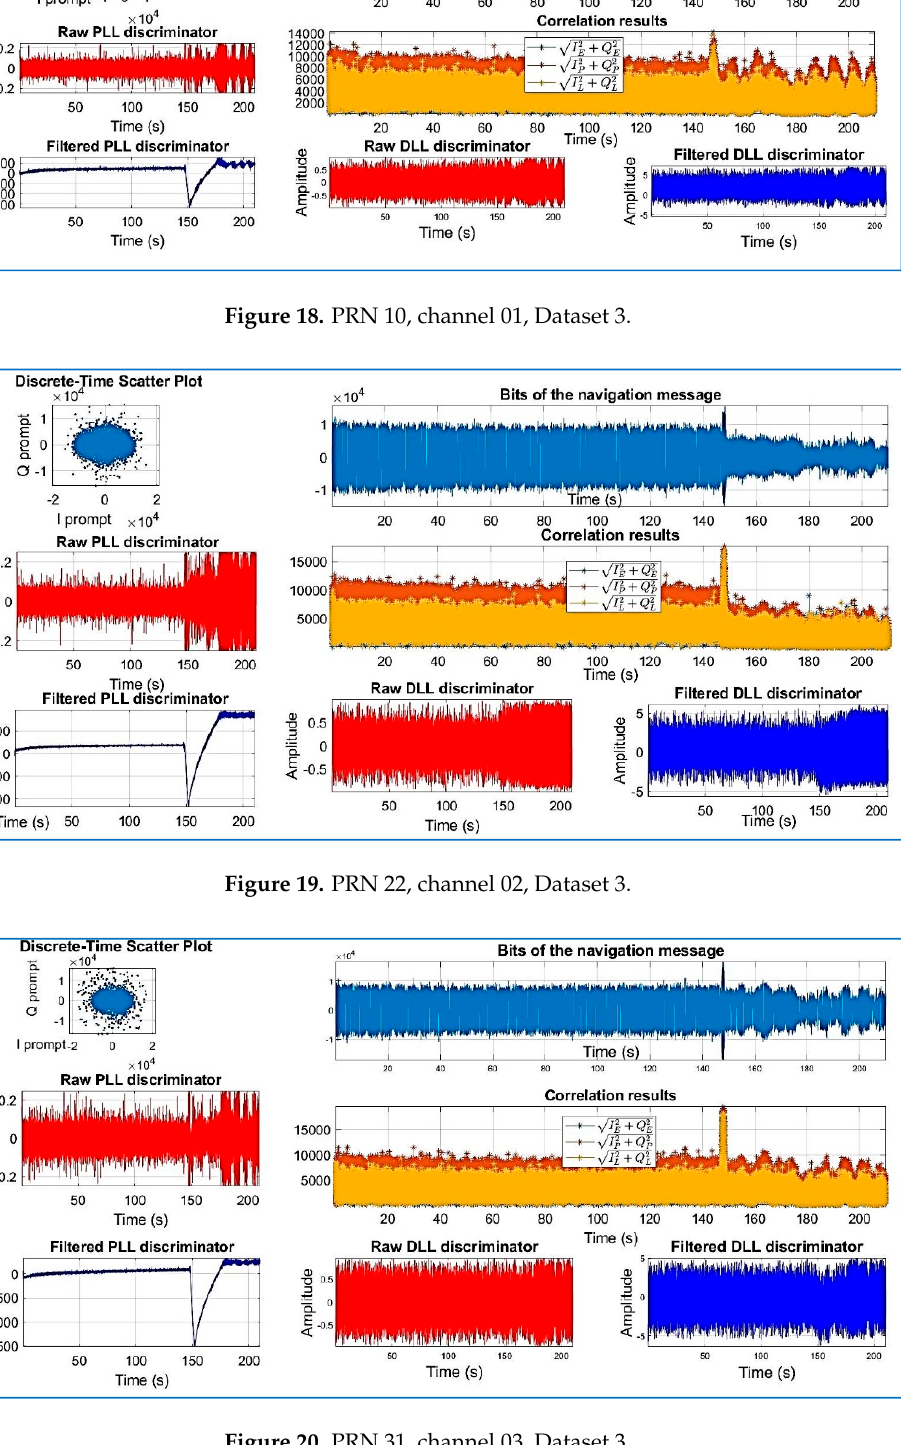
Figure 20. PRN 31, channel 03, Dataset 3.